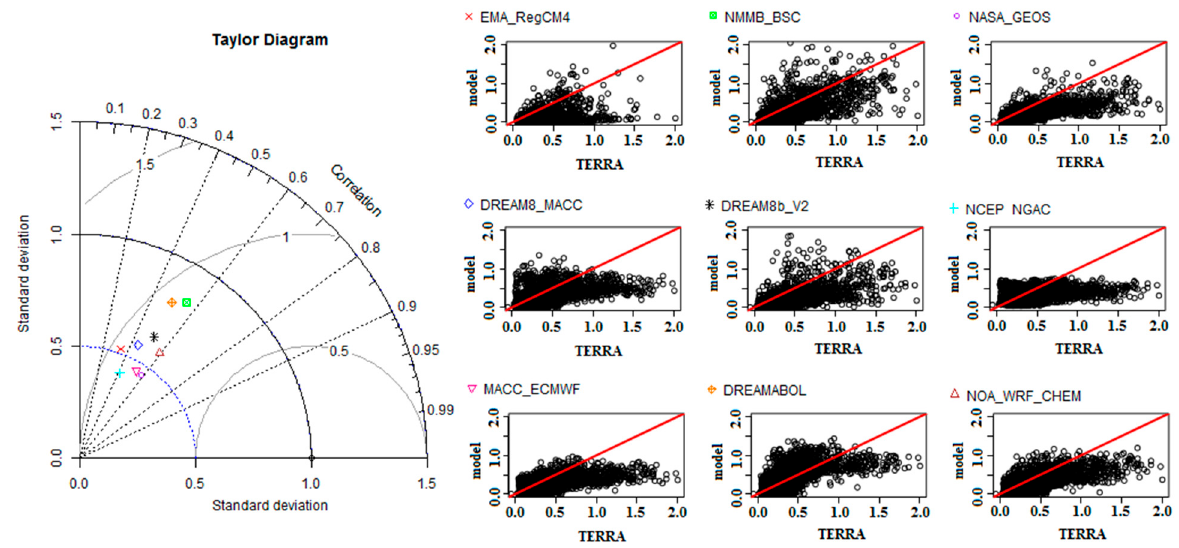
Figure 11. Taylor diagram and scatter plots of AOD values from model outputs and Terra-MODIS observations over the Middle East during Shamal dust storms.